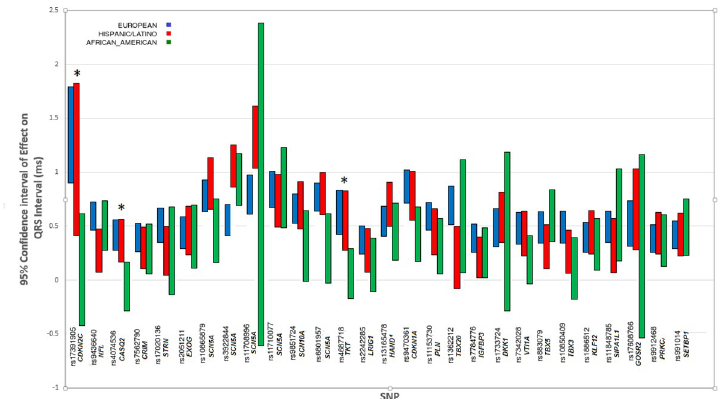
Fig 4. Transethnic comparison of QRS effect sizes for previously known SNPs. Comparison of effect sizes and 95% confidence intervals for 28 previously discovered SNPs for QRS duration across European, Hispanic/Latino, and African American GWAS results. Findings are largely similar across ethnic groups. � Refers to SNPs where the difference in effect size between two ethnic groups was significant at the Bonferroni corrected P -value. See S7 Table for additional